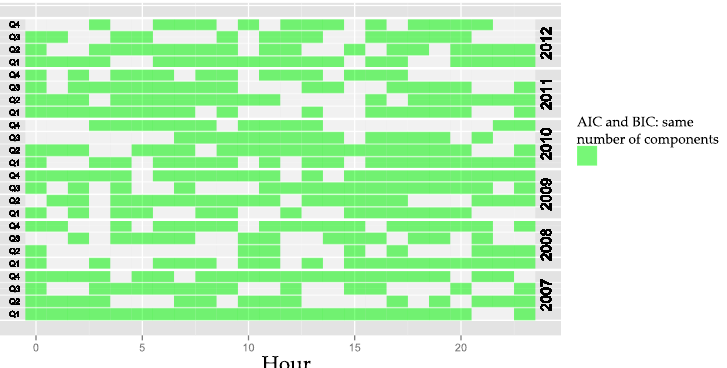
Figure 7. Weibull mixture model divided into quarters from aggregated wind power generation data (2007–2012). Hours with similar optimal number of components for AIC and